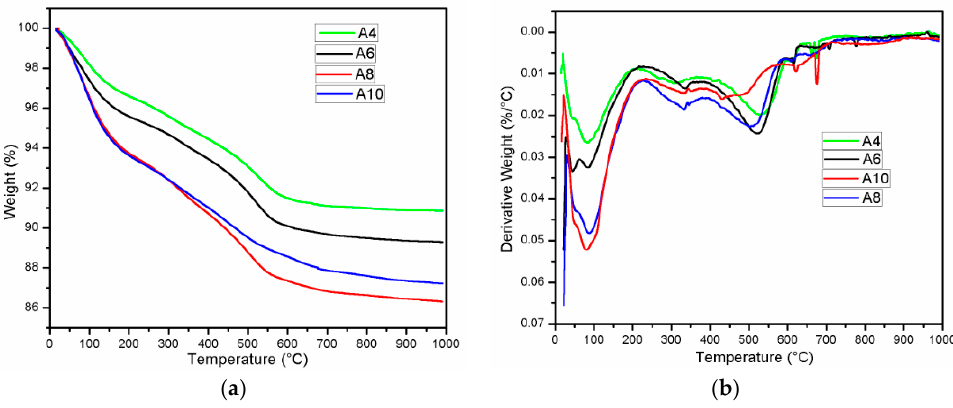
Figure 9. Thermogravimetric analysis (TGA) analysis ( a ) and Derivative thermogravimetric (DTG) analysis result ( b ) for AAS mortar at 28 days.